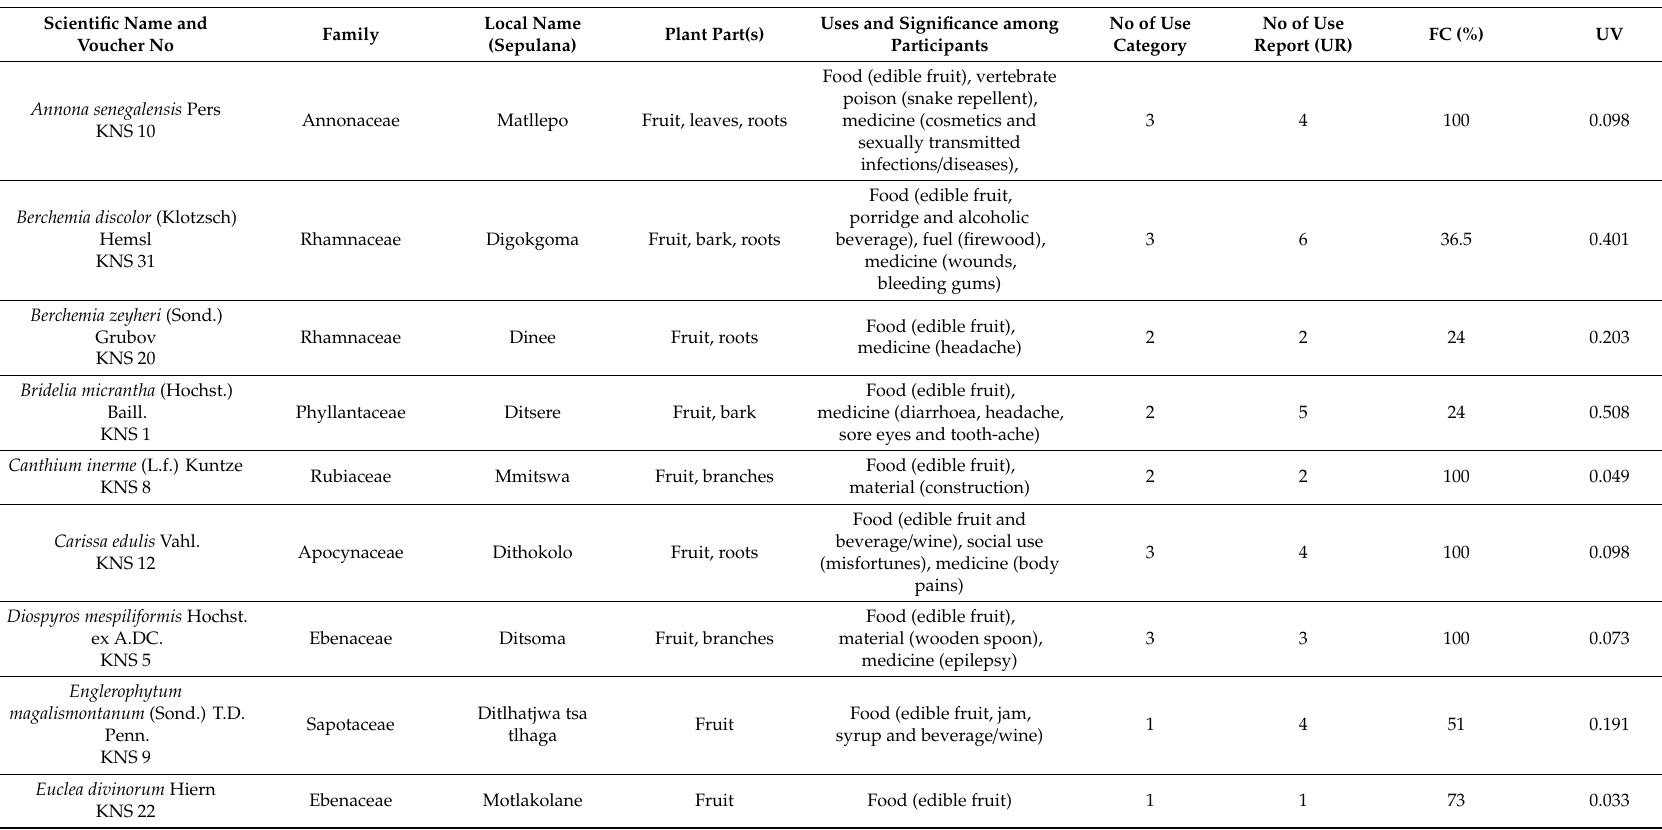
Table 2. An inventory of locally sourced fruit species among three villages in Bushbuckridge Local Municipality, Mpumalanga Province, South Africa. Use value (UV), frequency of citation (FC), and use report